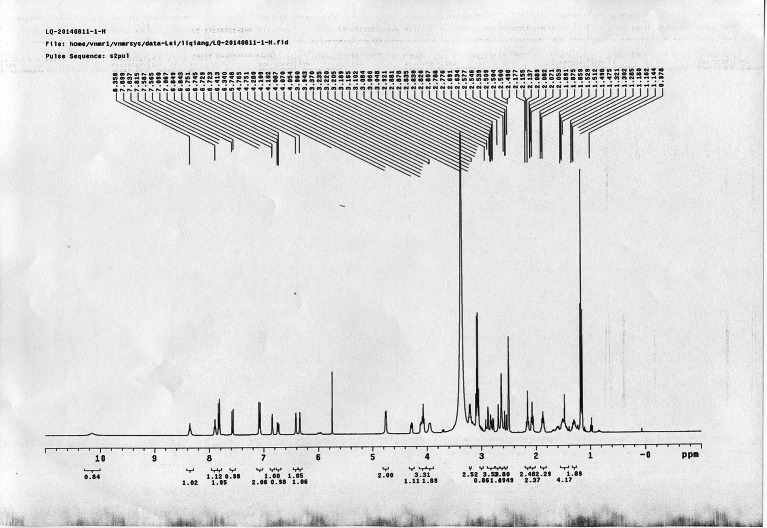
1H NMR spectra of d6-bAL 2.